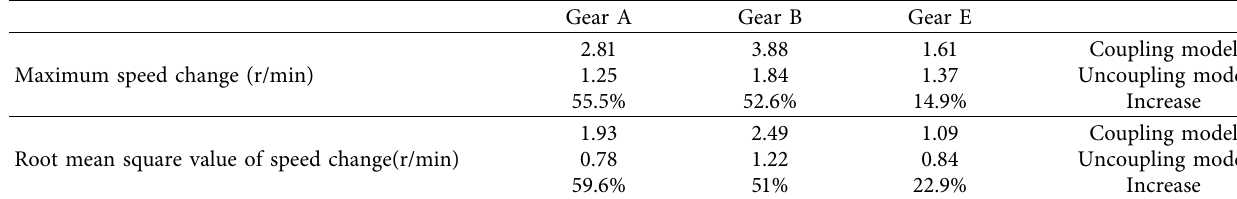
-1.5-1-0.500.511.5 Figure 22: The mass point torsional vibration response in two simulation conditions. (a) Time-domain diagram of gear A speed. (b) Frequency domain diagram of gear A speed. (c) Time-domain diagram of gear B speed. (d) Frequency domain diagram of gear B speed. (e) Time-domain diagram of gear E speed. (f) Frequency domain diagram of gear E speed. Table 6: Comparison of torsional vibration